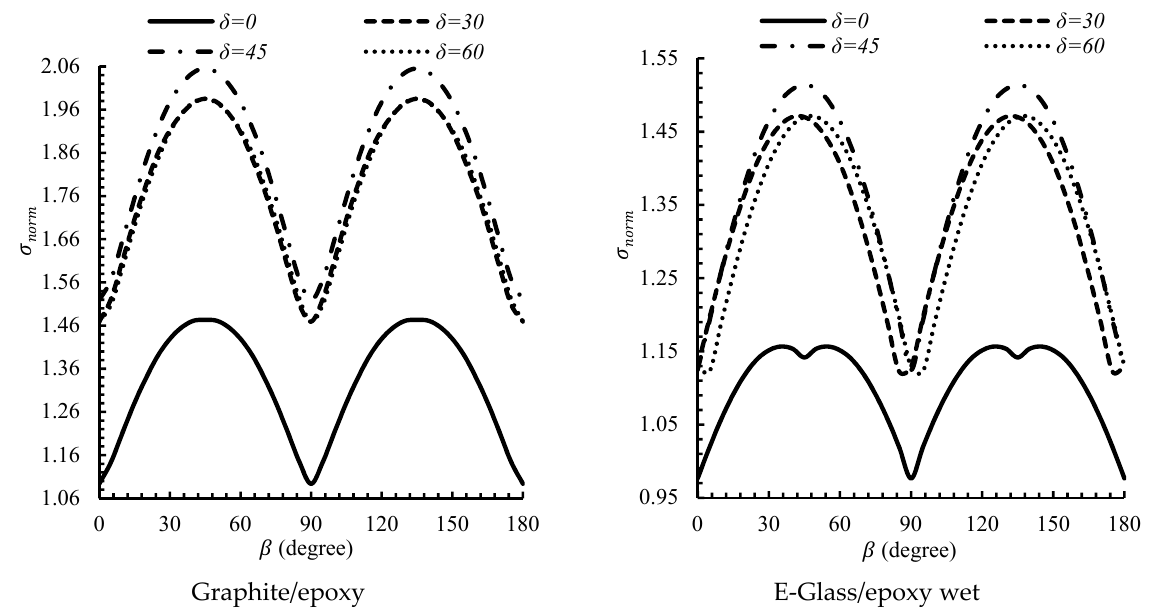
Figure 8. Effect of hole rotation angle on the maximum normalized stress in different values of δ .